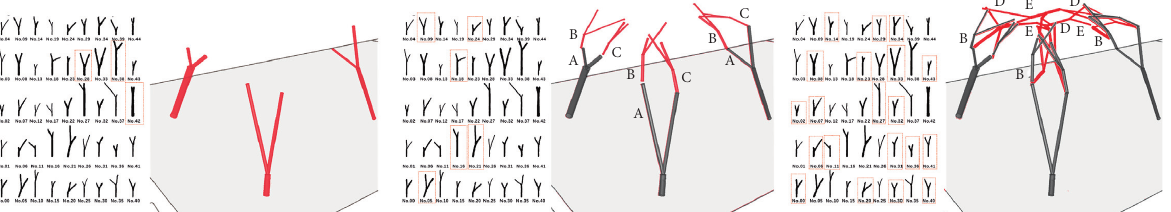
Figure 8: Information abstraction.